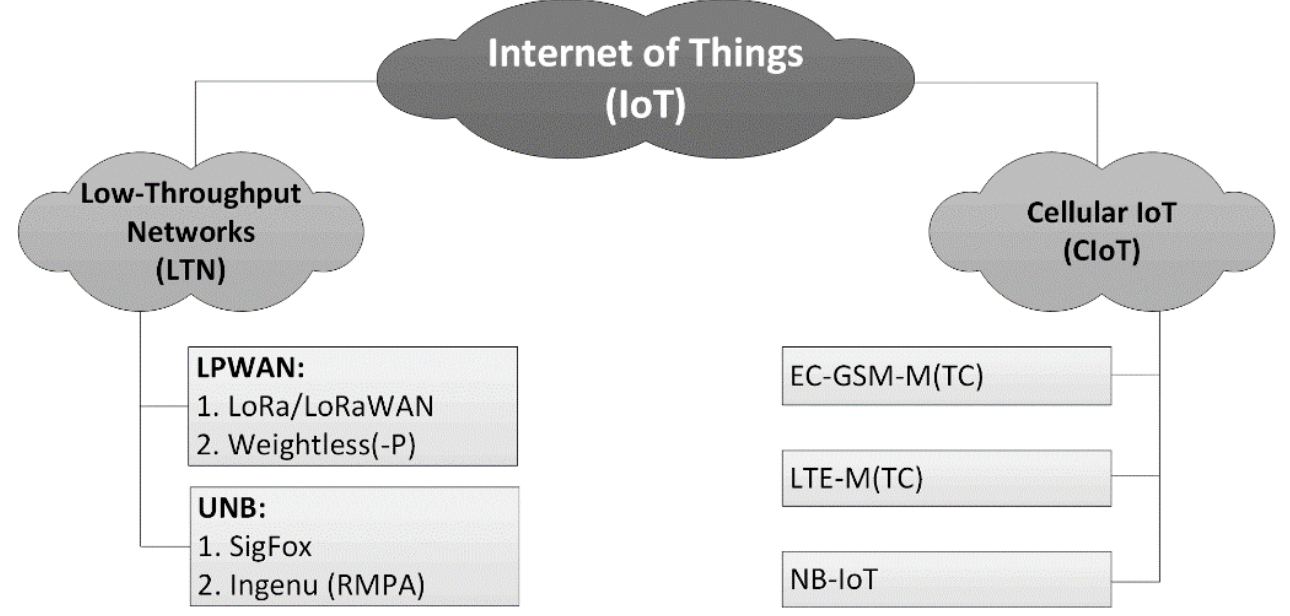
Figure 2. Schematic of a macro division of the IoT systems.